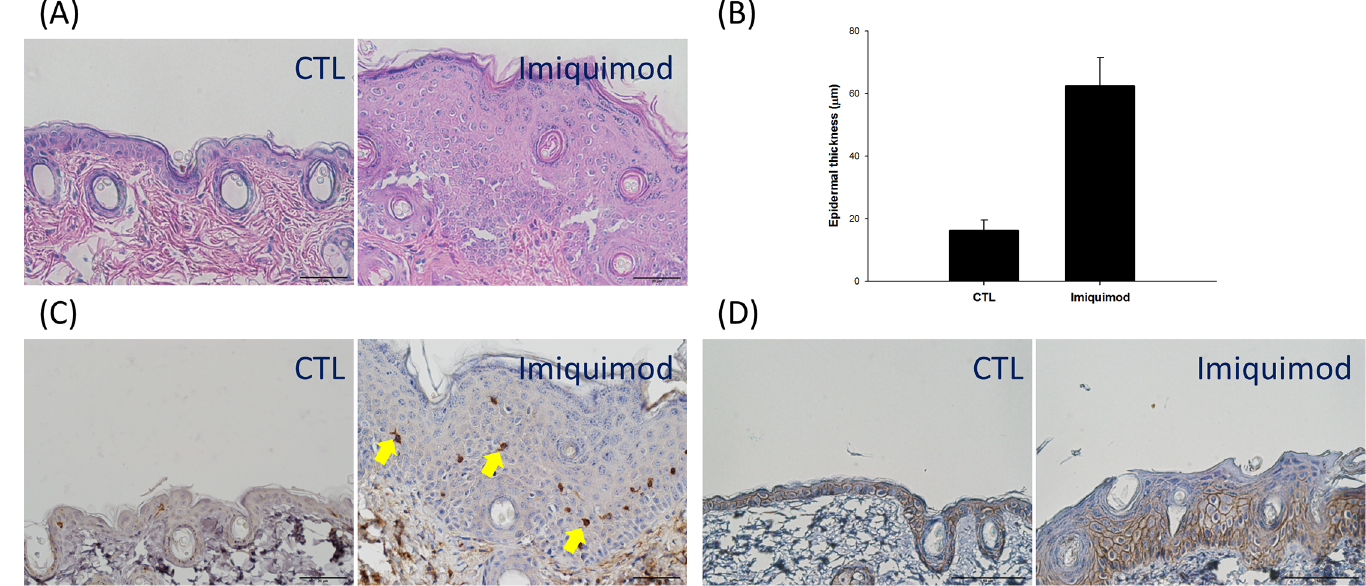
Fig 2. Histological and immunohistochemical examination of mouse skin treated with and without imiquimod cream: (A) hemoxylin and eosin (H&E) staining; (B) the epidermal thickness measured by H&E staining; (C) CD3 + T cell staining; and (D) β -catenin. The control group corresponds to the mice treated with the vehicle.